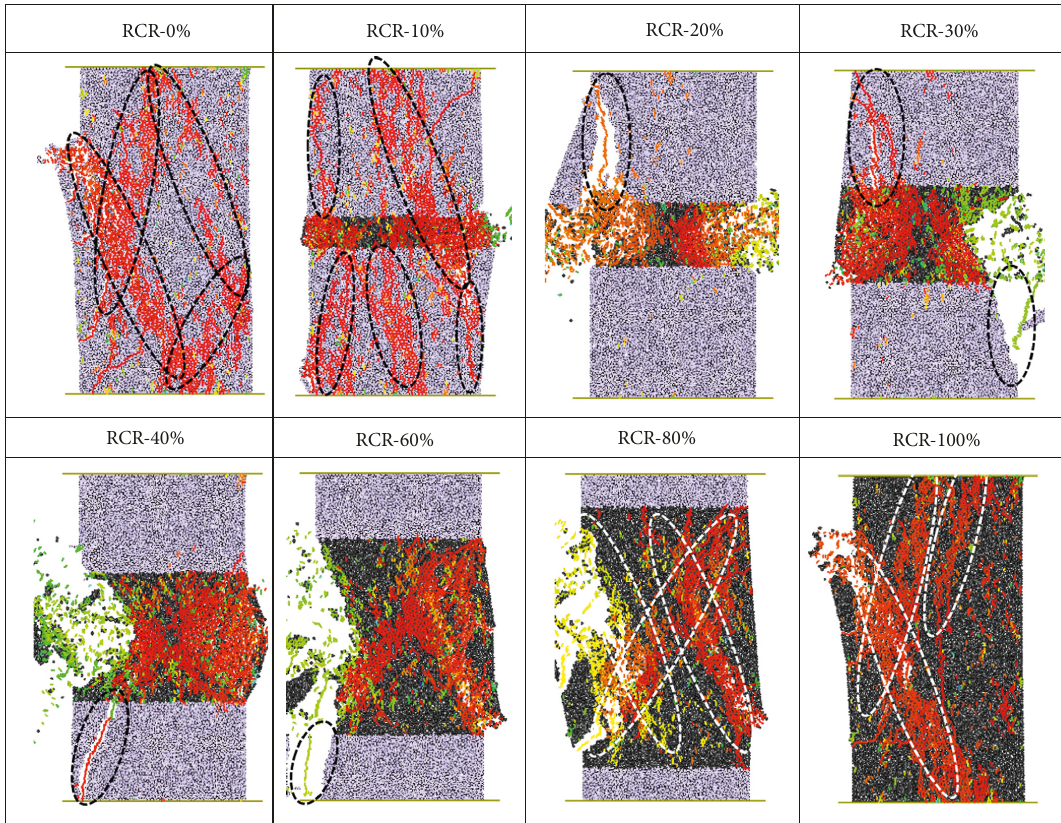
Figure 17: Failure modes of the RCR